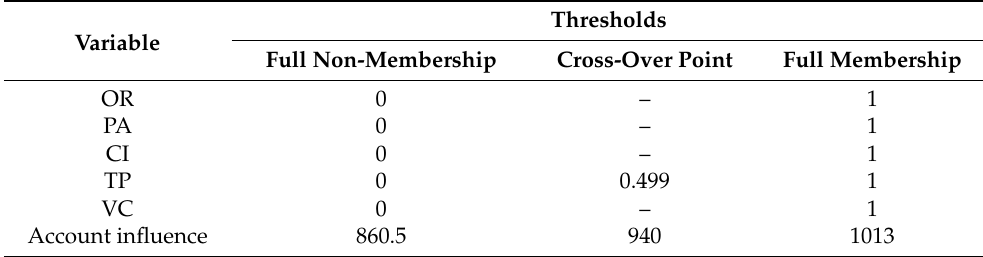
Table 2. Variables and calibration types.